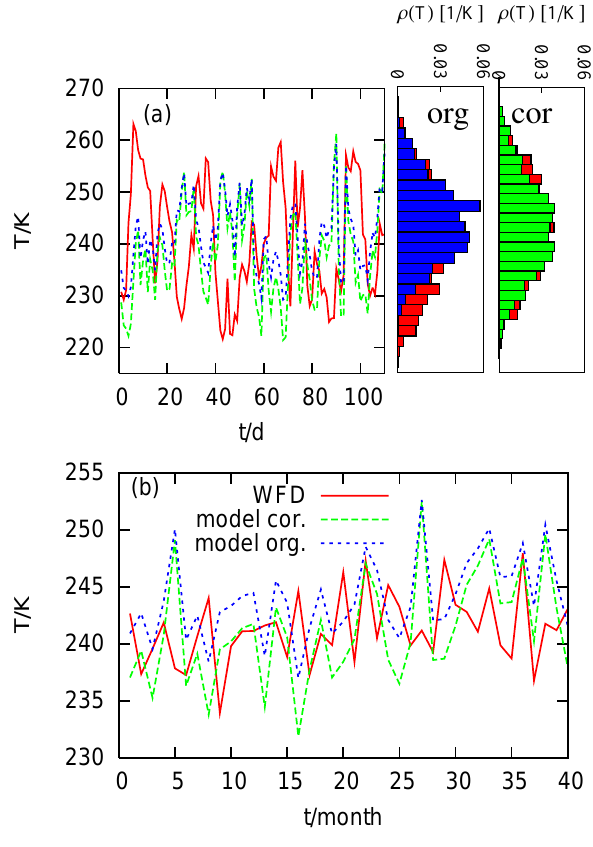
Fig. 5. Time series of observational, original and corrected model data for daily ( a ) and monthly ( b ) values at location (61.25 ◦ N, 112.25 ◦ E) marked in Fig. 4a; in (a) we also show the histograms of the observational (red), the original (blue) and corrected (green) model data.